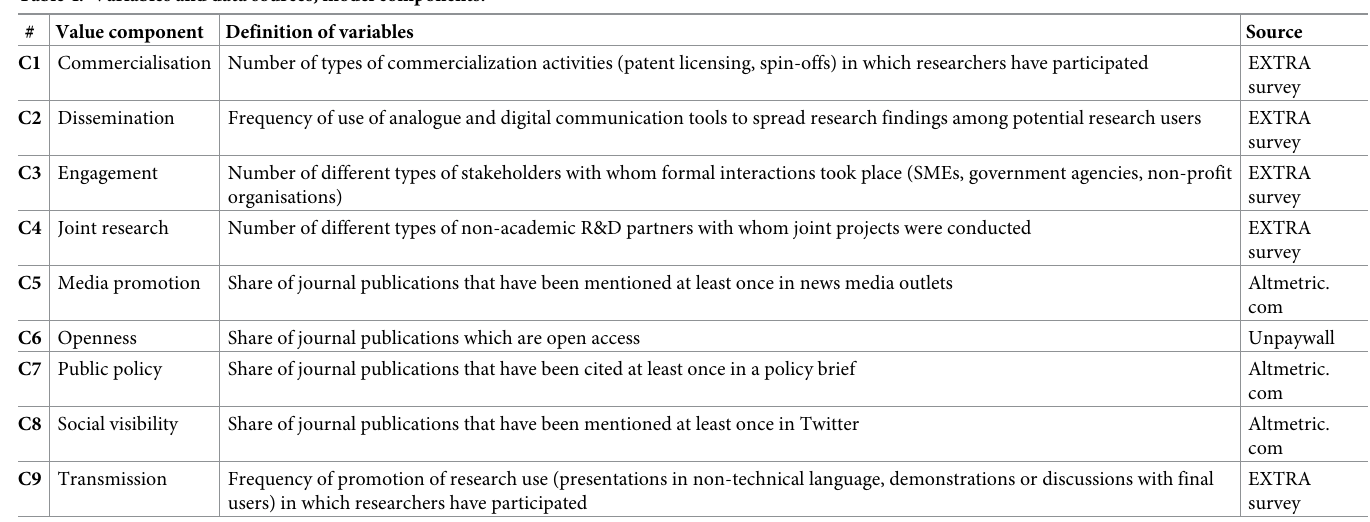
Table 4. Variables and data sources, model components.